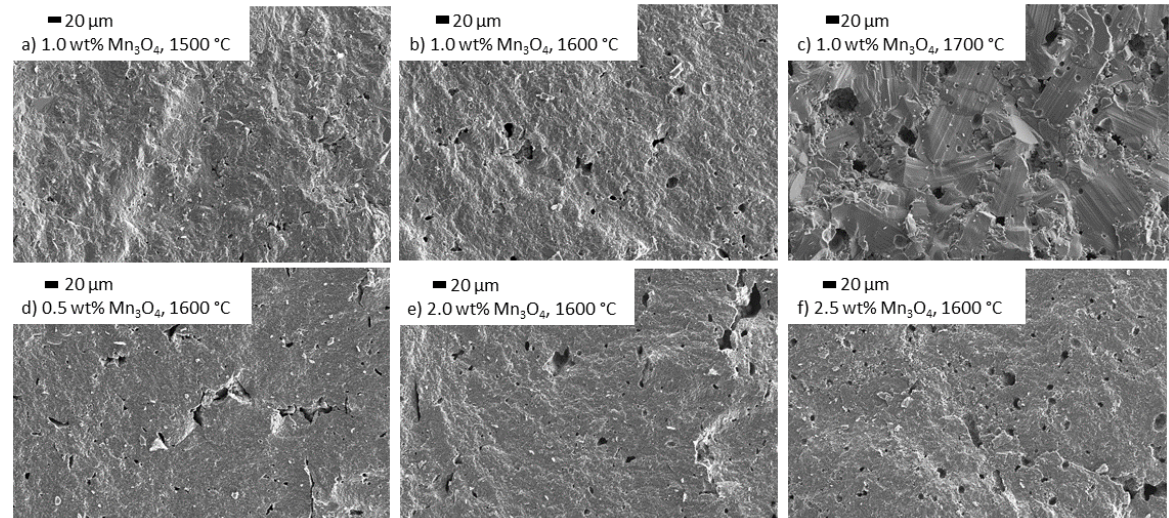
Figure 11. SEM images of Na- β″ -alumina samples sintered at 1500 °C, 1600 °C, or 1700 °C, doped with different amounts of Mn 3 O 4 ( b – f ) in comparison to an undoped sample ( a ).